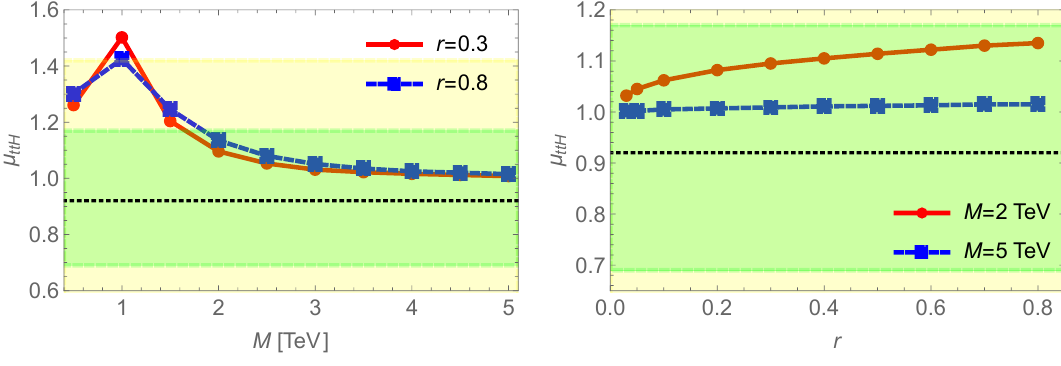
, as a Figure 12 . Ratio of the total cross-section pp → t ¯ tH with respect to the SM value, µ th t ¯ tH function of the renormalized on-shell mass M (left panel) for the fixed ratios r = 0 . 3 (red solid line) and r = 0 . 8 (blue dashed line), and as a function of the ratio r (right panel) for the fixed masses M = 2 TeV (red solid line) and M = 5 TeV (blue dashed line). The different lines correspond to the predictions based on the full propagator (pole approach), while the bands represent 1 σ (light green) and 2 σ (light yellow) deviations from the µ obs central value (black dotted line) observed by t ¯ tH the CMS collaboration